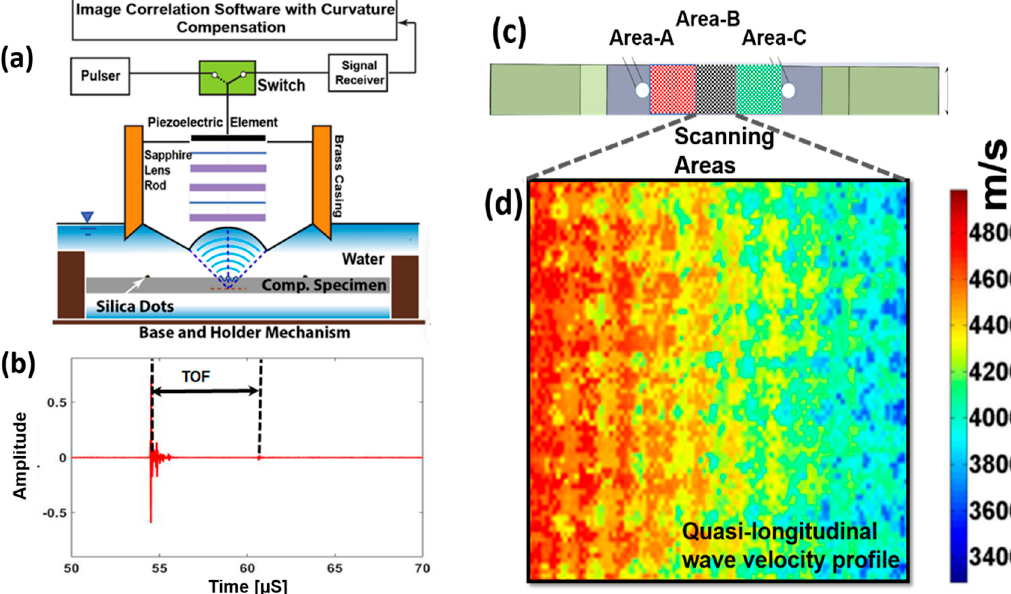
Figure 2. ( a ) Schematic of Scanning Acoustic Microscopy (SAM); ( b ) A typical A-Scan signal at a pixel point; ( c ) scanning areas on the specimen; ( d ) quasi-longitudinal wave velocity profile on a selected area.